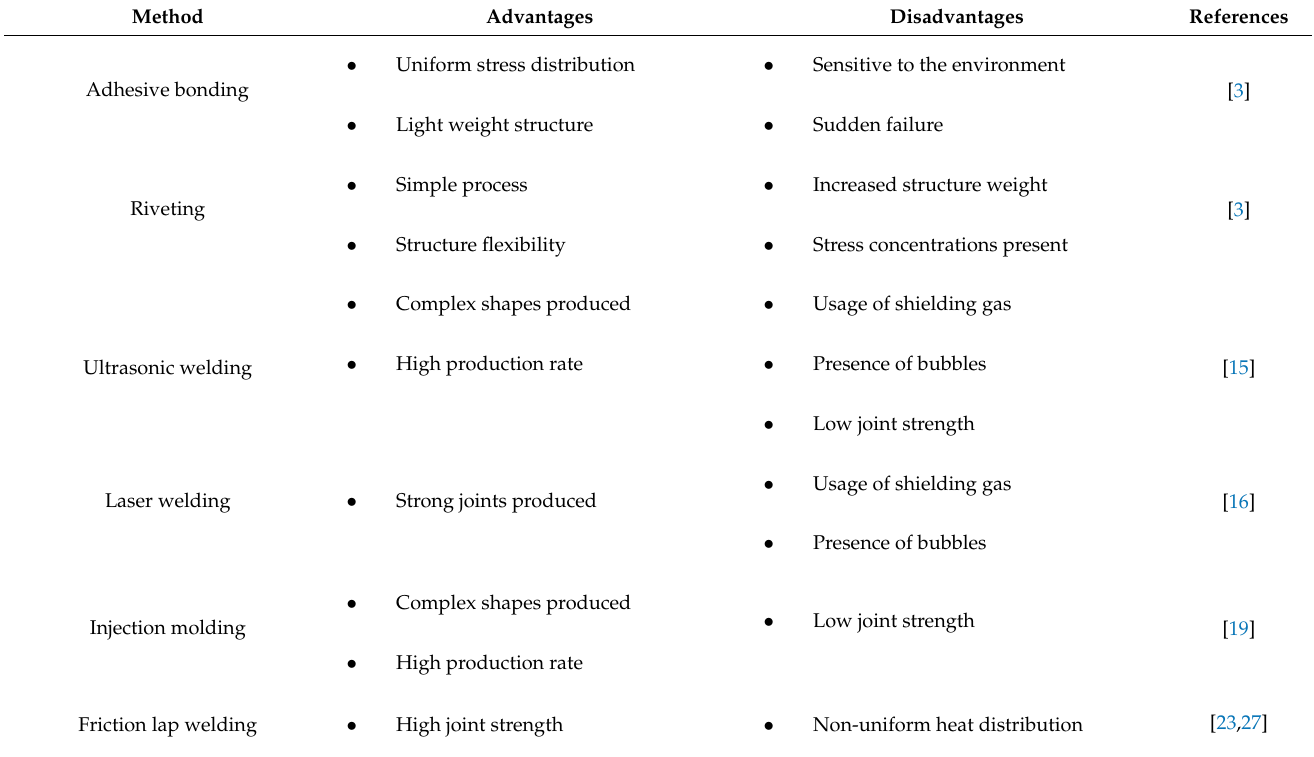
Table 1. Advantages and disadvantages of metal-to-polymer joining